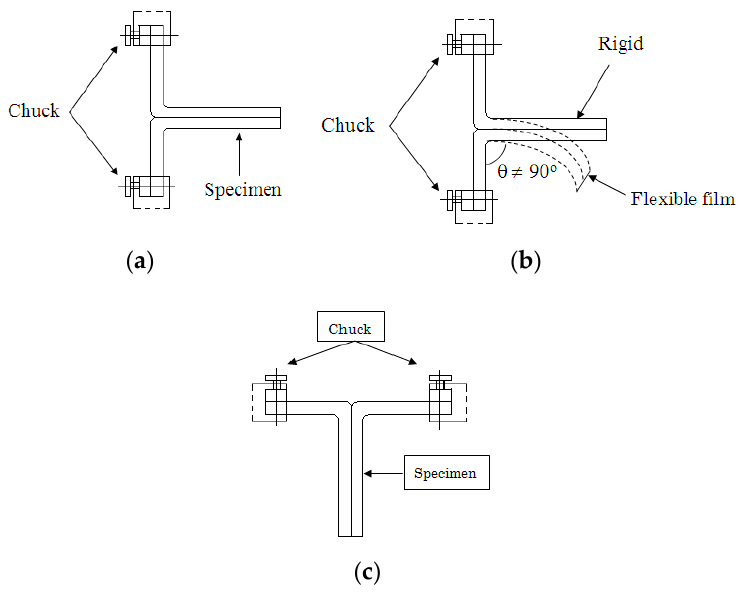
Figure 2. ( a ) Standardized T-peel test method Japanese Industrial Standard (JIS) [27] and American Society of Testing and Materials (ASTM) [28] and ( b ) Failure of flexible film specimen to stabilize the peel angle, ( c ) the new testing apparatus for T-peel test as shown in Figure 1.